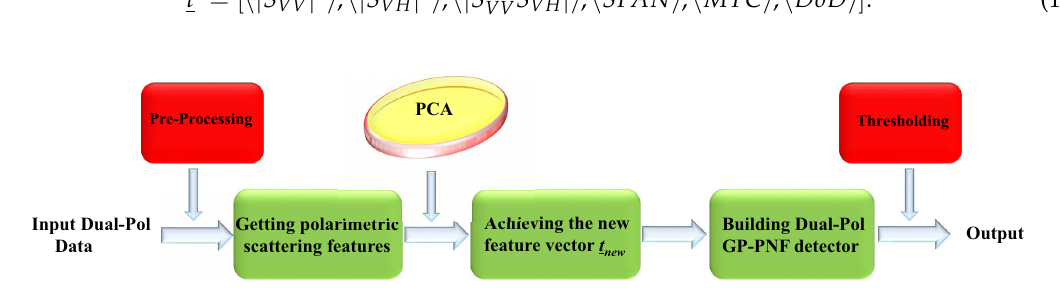
Figure 1. The flowchart of the proposed